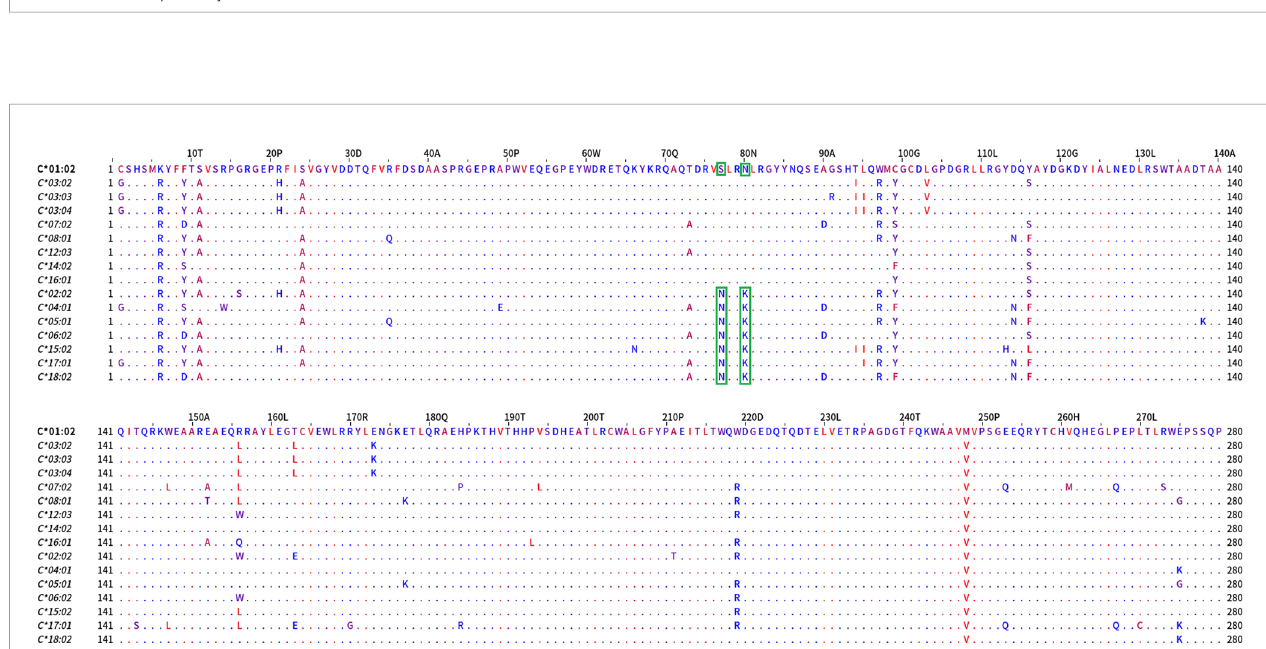
FIGURE 6 | PCA biplots of the anti-HLA-C immune response. Panel (A) on the left represents the de fi ned plane of the fi rst and second principal components while Panel (B) on the right represents the de fi ned plane of the second and third principal components. The points represent projections of individual reactions and arrows the different anti-HLA-C antigen-speci fi c responses. The color vectors on the right side of both panels represent the cos2 value of the explained variance for variables and individuals respectively.